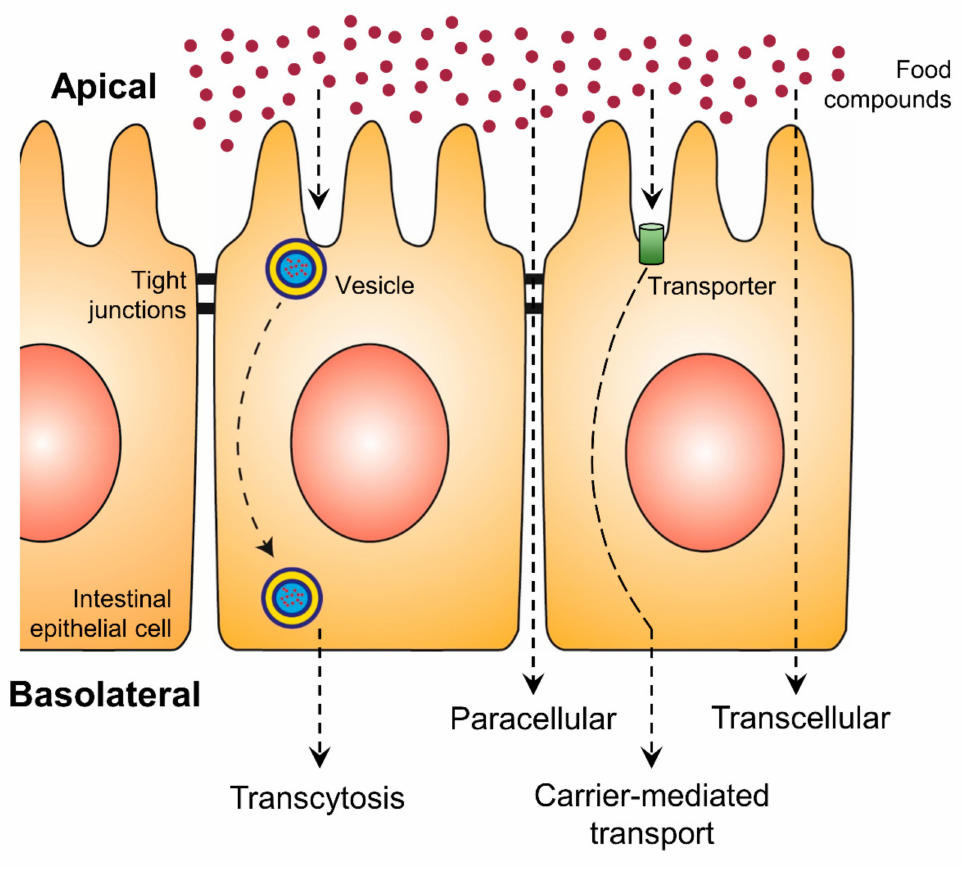
Figure 2. Uptake of food compounds by intestinal epithelial transport mechanisms from the gut lumen (apical side) to the blood vessel (basolateral